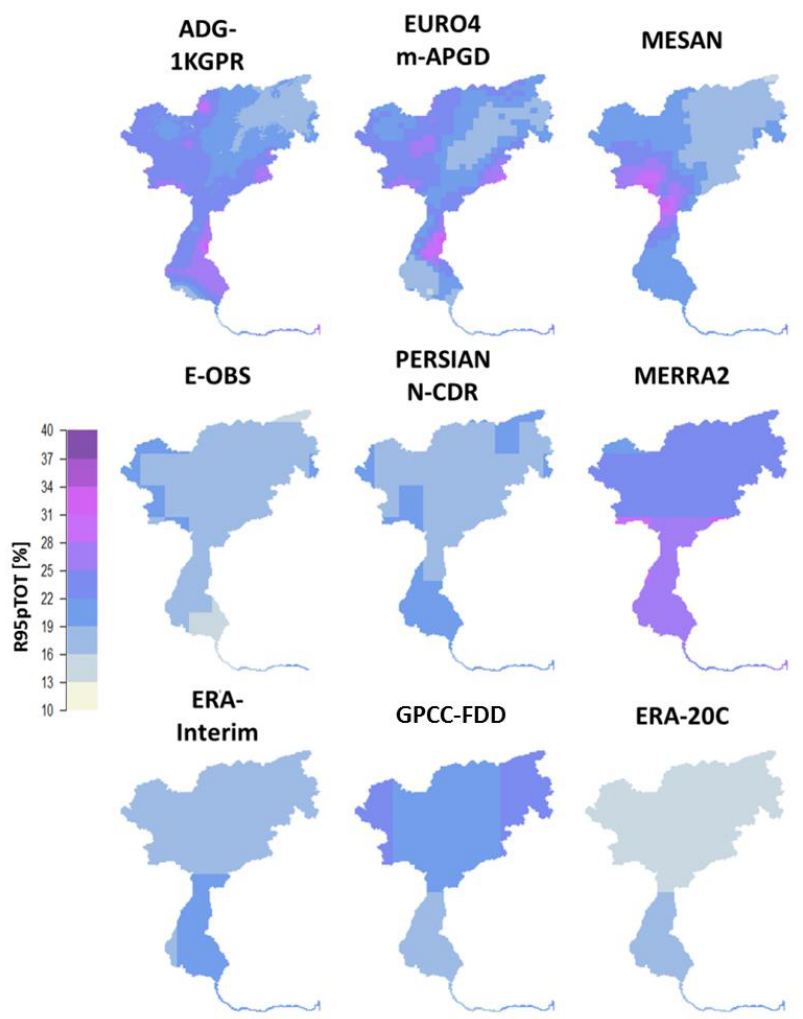
Figure 10. Contribution of heavy precipitation (>95th percentile) to annual precipitation in % (R95pTOT) for the reference grid and the selected data sets.